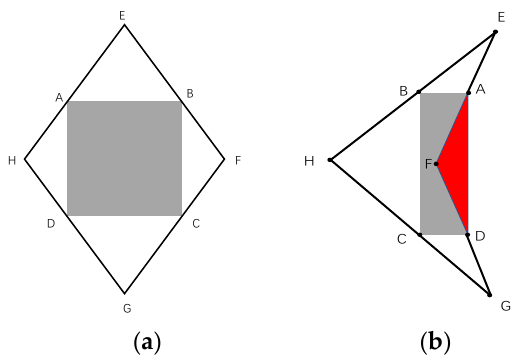
Figure 2. An example of a failure for VJM.